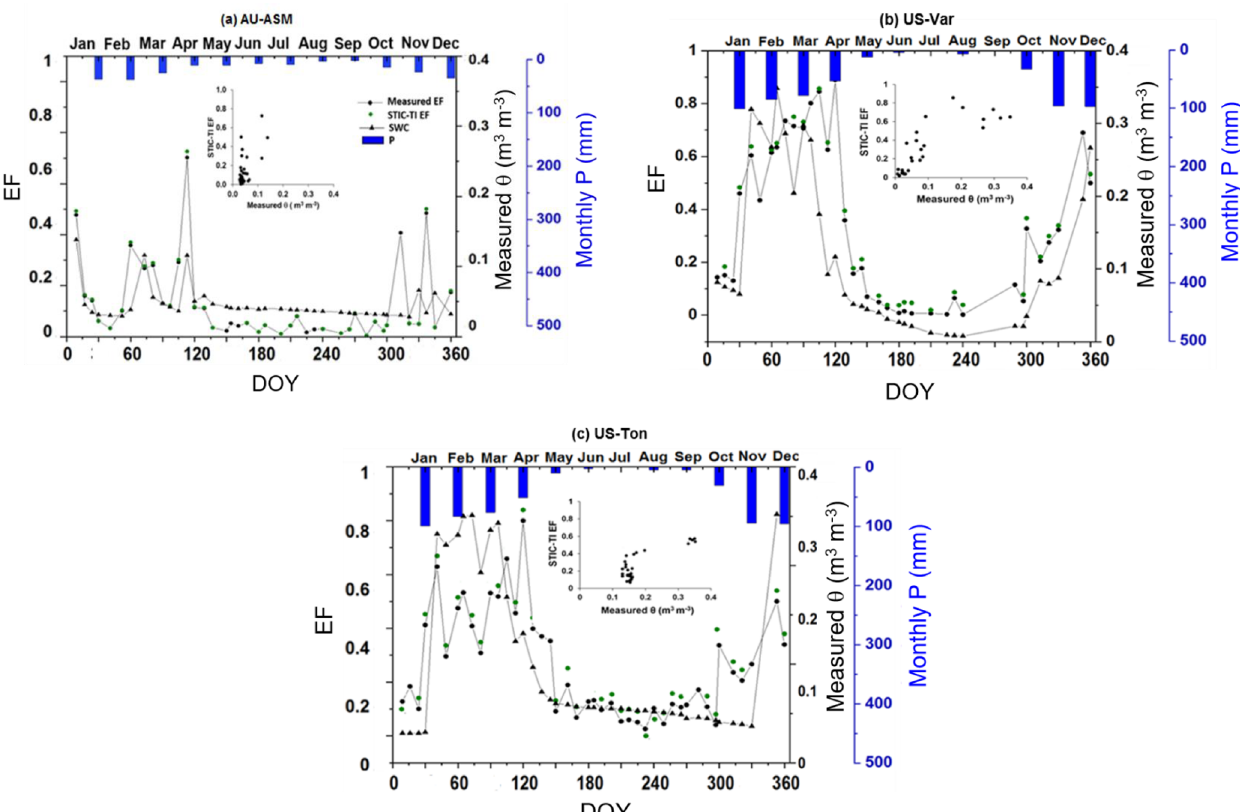
Figure 13. Comparison of the temporal variation of STIC-TI-derived EF using the MYD11A2 LST with respect to measured EF, θ , and P in (a) AU-ASM, (b) US-Var, and (c) US-Ton. The scatterplots in the inset show the relationship between STIC-TI EF with respect to measured θ .